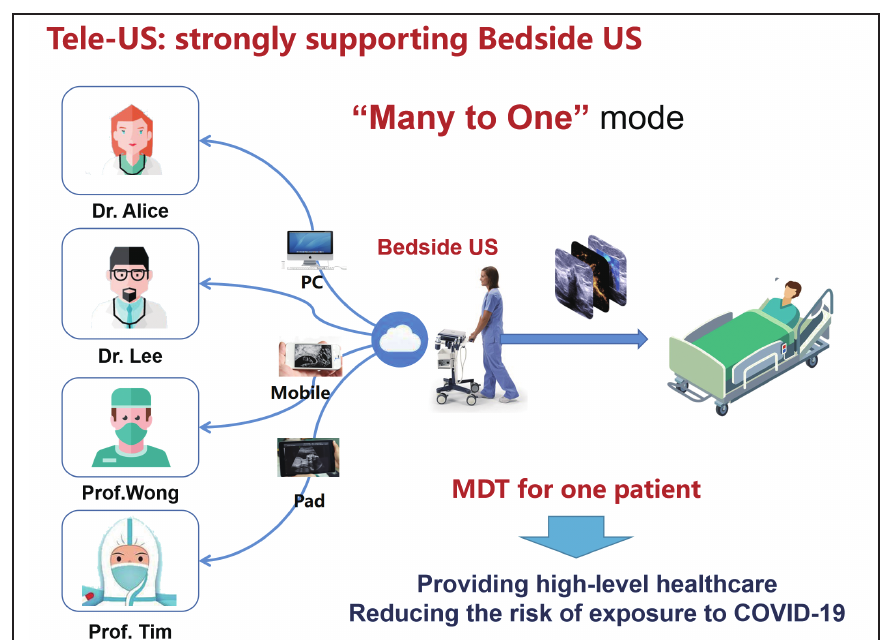
Figure 22 Schematic diagram of the basic structure of remote